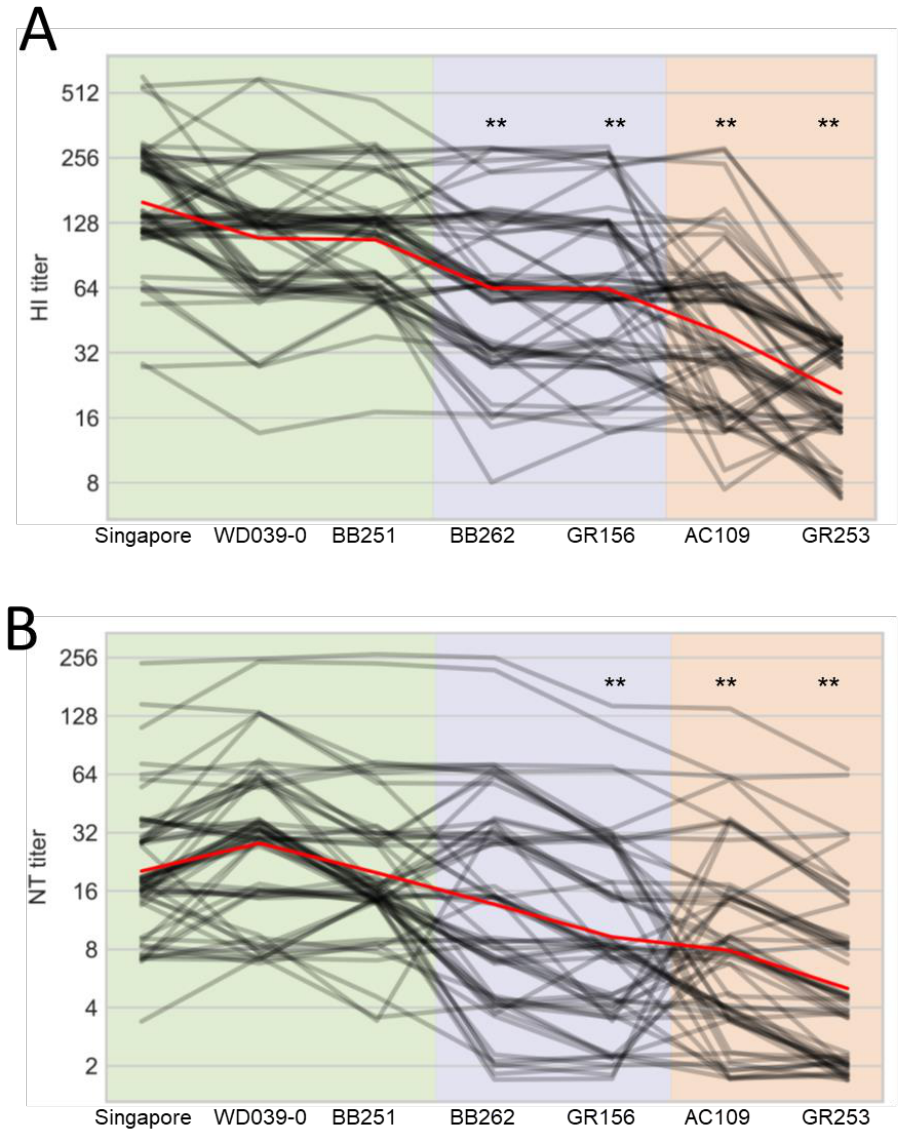
Figure 4. Reactivity of human plasma samples against A(H1N1)pdm09 viruses. HI ( A ) and neutralization ( B ) titers of 63 human serum samples against the indicated seven viruses are plotted as black lines; a small amount of vertical jitter has been added to prevent lines from overlapping each other. The mean of all individuals is shown in red. Antigens are grouped on the x -axis according to the substitutions of interest. Viruses are abbreviated as follows: A/Singapore/GP1908/2015 (Singa- pore); A/Tokyo/UT-WD039-0/2019 (WD039-0); A/Tokyo/UT-BB251/2019 (BB251);